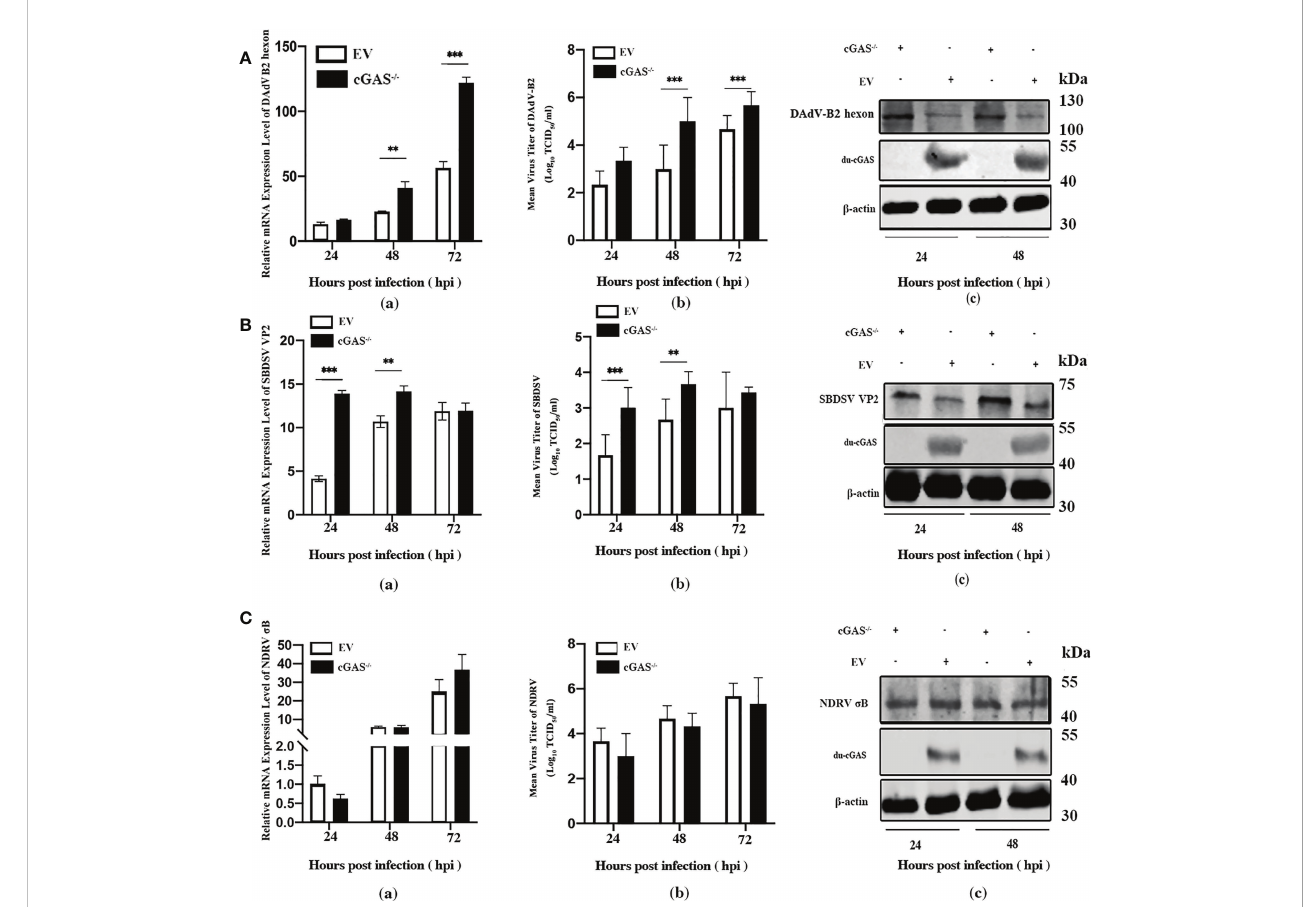
FIGURE 3 Knockout endogenous du-cGAS greatly promotes DNA viruses ’ replication. The du-cGAS -/- and EV DEF cells were infected with DAdV B2, SBDSV, and NDRV at the MOI of 0.25 and harvested at 24, 48, and 72 hpi respectively. The relative mRNA expression levels of the viral gene in the infected DEF cells were determined by qRT-PCR, and the viral titers in the cell culture supernatant were detected by TCID 50 assay. The expression levels of viral protein in infected DEF cells were detected by western blotting. (A) DAdV-B2 infection. (B) SBDSV infection. (C) NDRV infection. Data represent the mean values ± SD, and statistical signi fi cance was analyzed by t-test. * P < 0.05, ** P < 0.01, *** P <